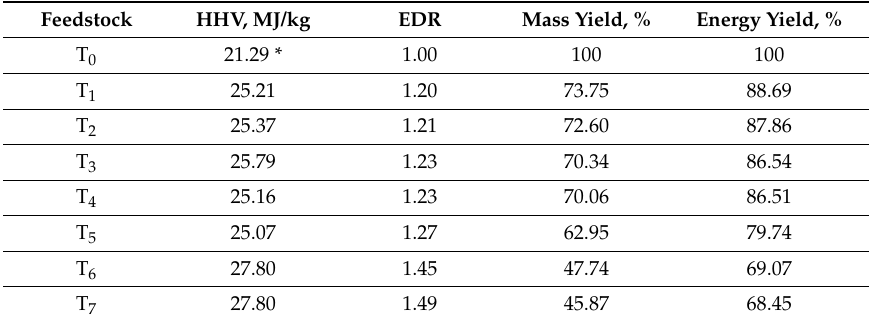
Table 3. Effect of processing conditions on the higher heating value (HHV), mass and energy yield.